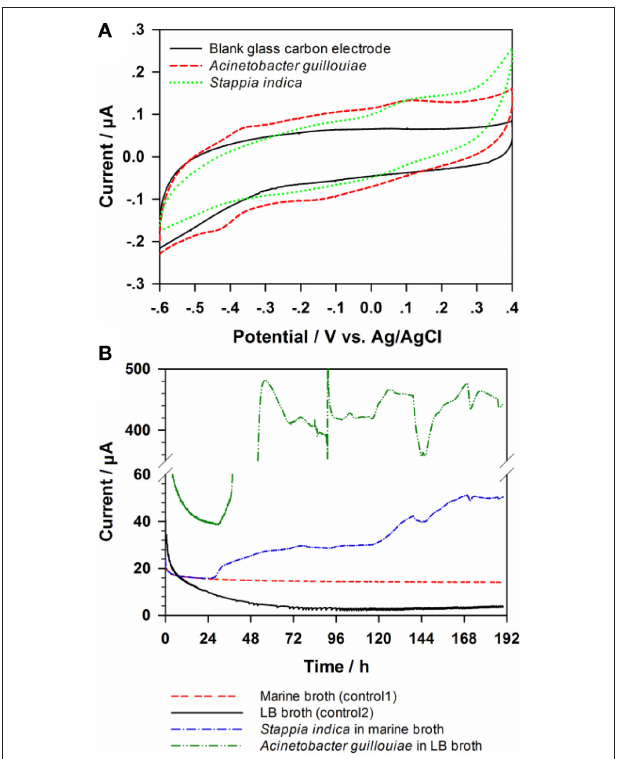
FIGURE 5 | Cyclic voltammetry (A) and chronoamperometry (B) tests for Stappia indica and Acinetobacter guillouiae